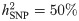
Theoretical predictions of power per causal SNP (upper panel) and out-of-sample R2 of the PGS (lower panel), for a trait with GWAS results from the number of studies (x-axis) with cross-study genetic correlation (y-axis).Factor levels: total sample size 250,000 individuals, 100k independent SNPs, and hSNP2=50% arising from a subset of 1k independent SNPs.